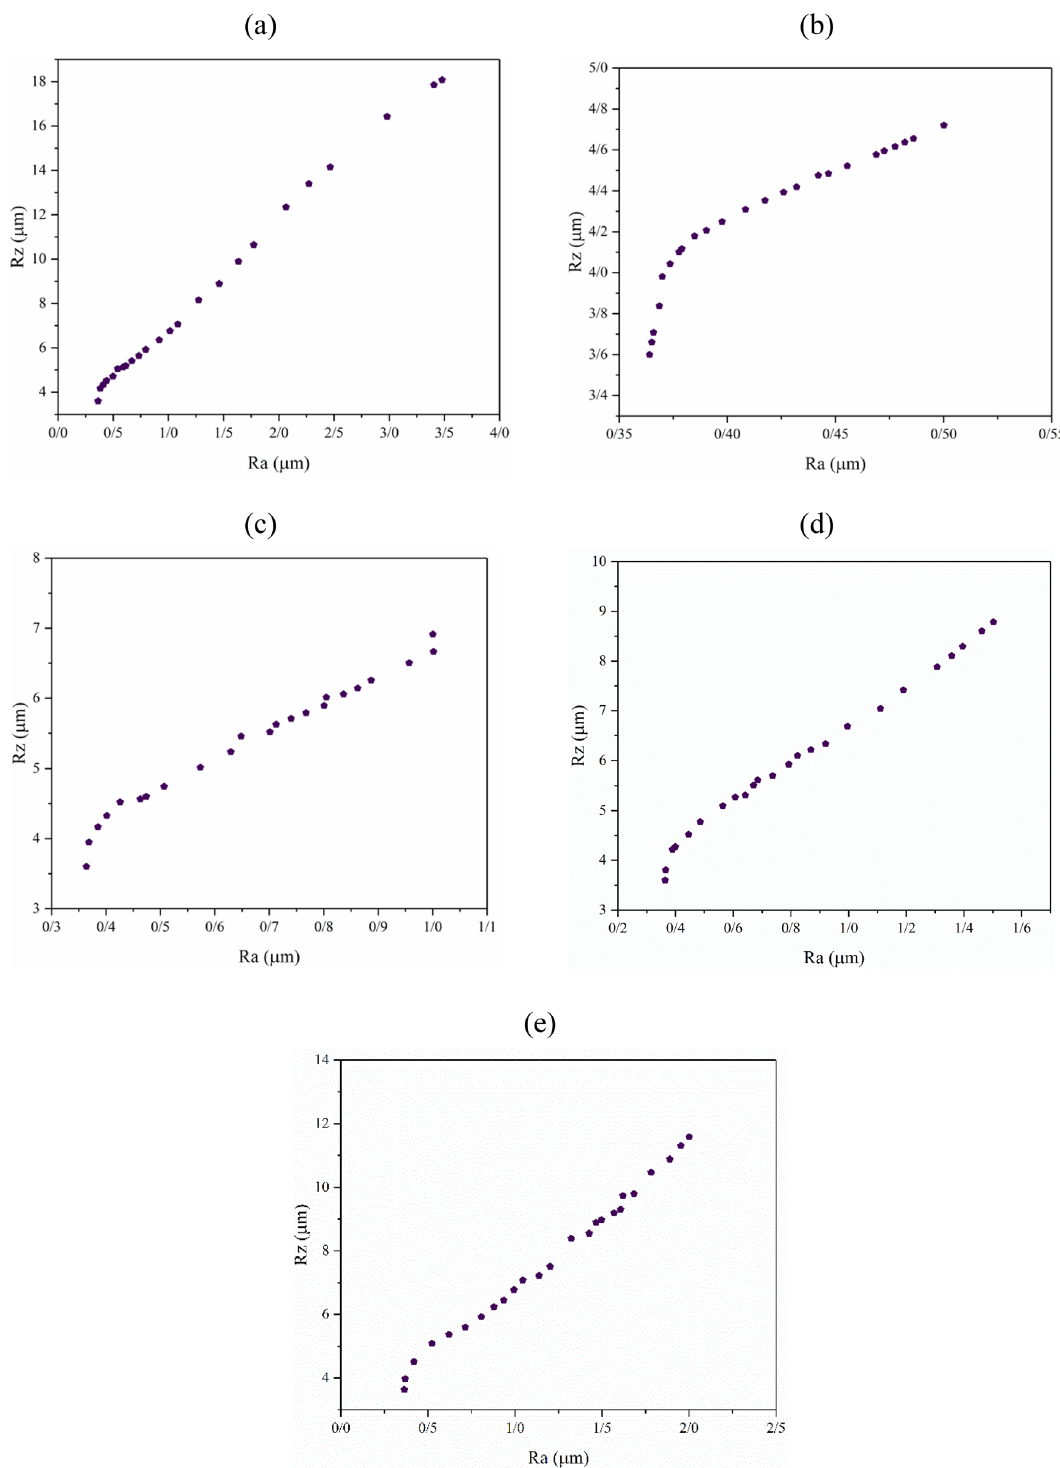
Figure 12. Multi-objective optimization of R a and R z in the etching of titanium to achieve ( a ) maximized R a and minimized R z , ( b ) fixed R a = 0.5 and minimized R z , ( c ) fixed R a = 1 and minimized R z , ( d ) fixed R a = 1.5 and minimized R z , and ( e ) fixed R a = 2 µm and minimized R z